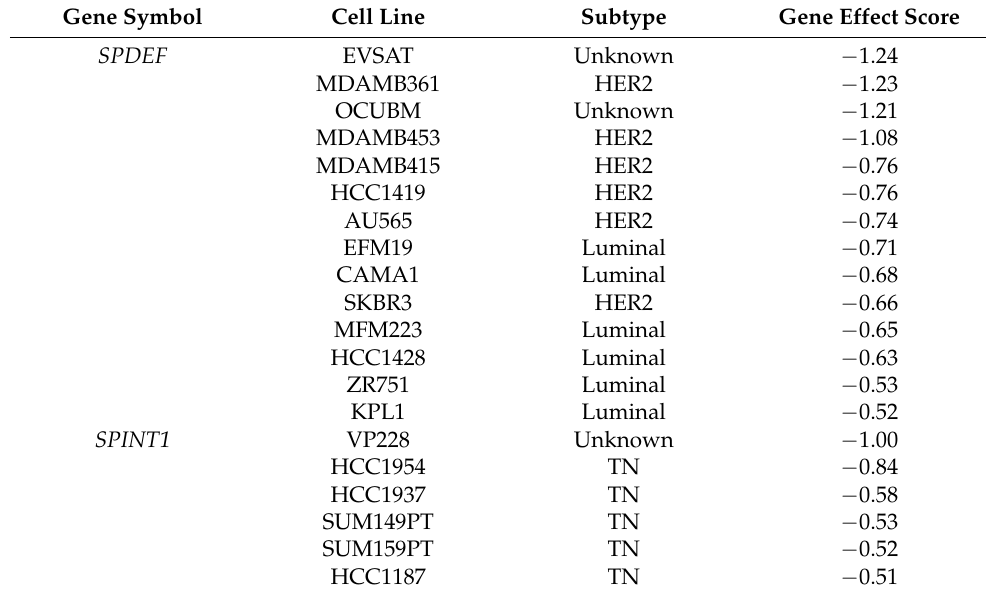
Table 2. Gene effect score of CRISPR (DepMap 22Q1 public + score, Chronos).